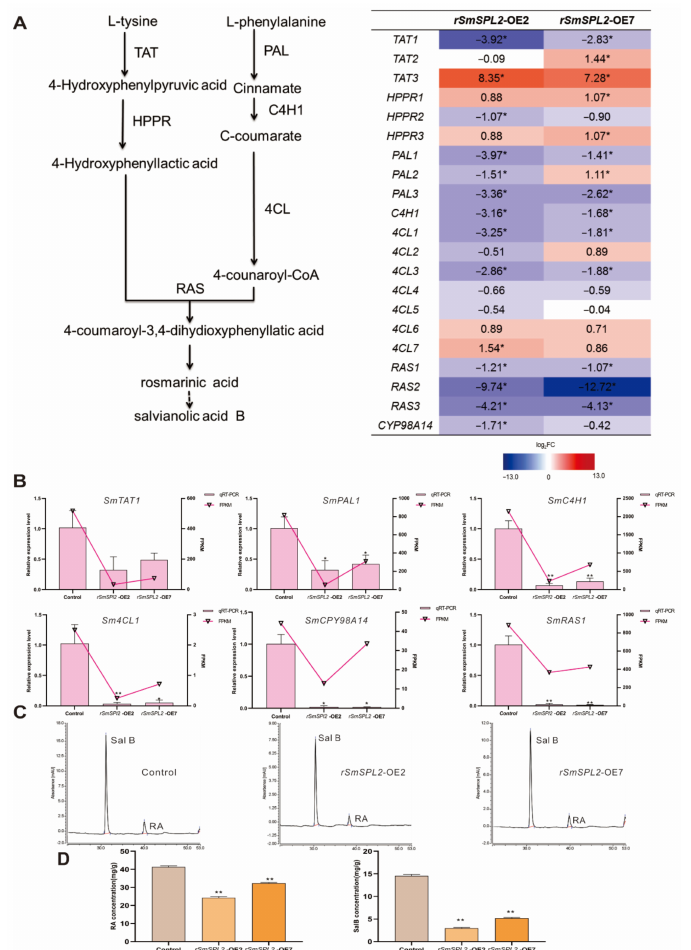
Figure 5. Overexpression of miR156-resistant SmSPL2 ( rSmSPL2 ) decreased the accumulation of rosmarinic acid (RA) and salvianolic acid B (SalB). ( A ) Transcriptome analysis of enzyme genes for salvianolic acid biosynthesis pathway in transgenic lines ( rSmSPL2 -OE2 and rSmSPL2 -OE7). For each gene, the relative expression ( rSmSPL2 -OE2 vs. control and rSmSPL2 -OE7 vs. control) was expressed as Log 2 FC. Blue boxes (gene expression is down-regulated); Red boxes (gene expression is up-regulated). TAT, tyrosine aminotransferase; HPPR, hydroxyl phenylpyruvate reductase; PAL, phenylalanine ammonia lyase; C4H, cinnamate 4-hydroxylase; 4CL, hydroxycinnamate-CoA ligase; RAS, rosmarinic acid synthase; and CYP, cytochrome P450 enzymes. ( B ) Validation by qRT-PCR of six enzyme genes involved in salvianolic acid biosynthesis in transgenic lines and control. ( C ) Chro- matograms of RA and SalB in transgenic lines and the control. ( D ) RA and SalB concentrations in the roots of two-month-old transgenic lines and the control. All data are mean values of three biological replicates, with the error bar representing SD. * and ** indicate significant difference from the control at p < 0.05 and p < 0.01 level, respectively, by Student’s t